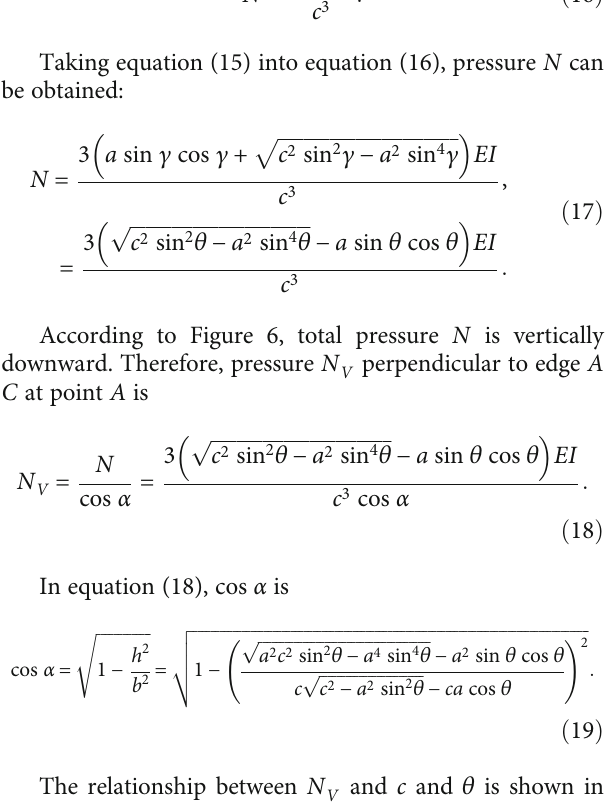
c , and θ relationship. A ,